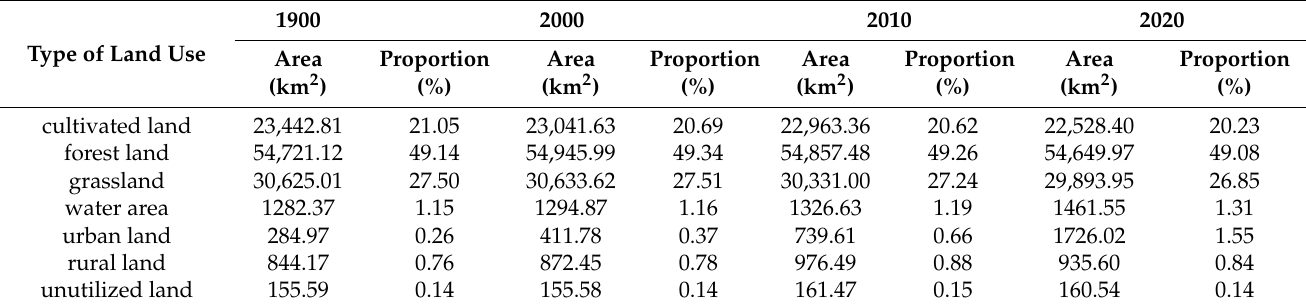
Table 4. Area and proportion of land use types in central Yunnan urban agglomeration,